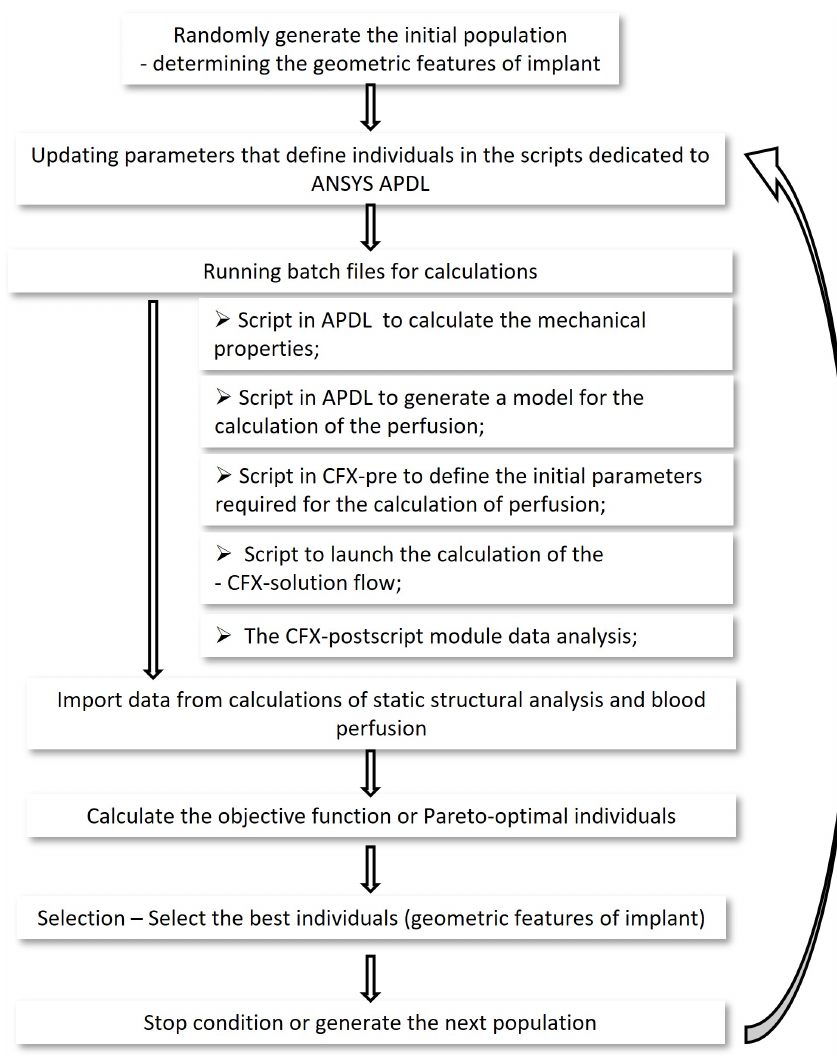
Figure 4. General algorithm of the immune system used.